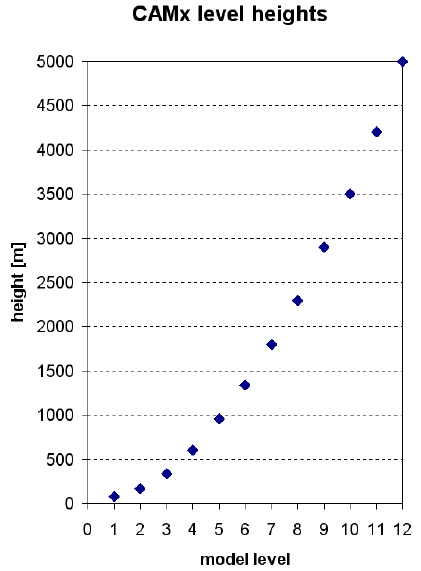
Fig. 5. Approximate heights (above the ground level) of the top of CAMx model layers in the performed simulations in